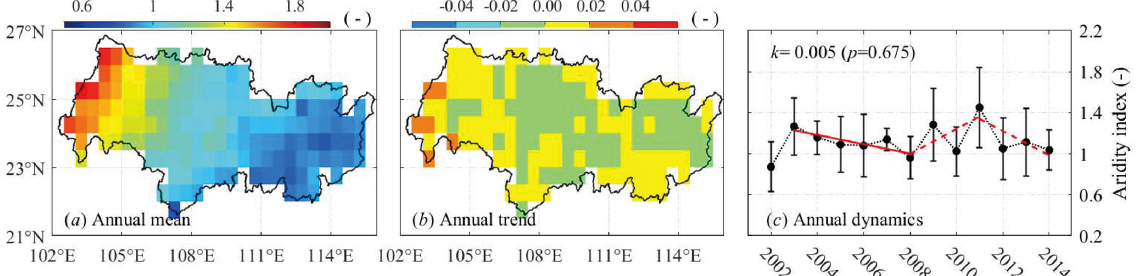
Figure 3. (a) Spatial distribution of the mean annual aridity index across the basin during hydrological years 2002–2014, (b) annual trend of aridity index, and (c) mean annual aridity index over the basin. Red lines show the periodic trends. The dashed red line indicates statistically insignificant trend. The coefficient of determination is 0.71, 0.47, and 0.61,